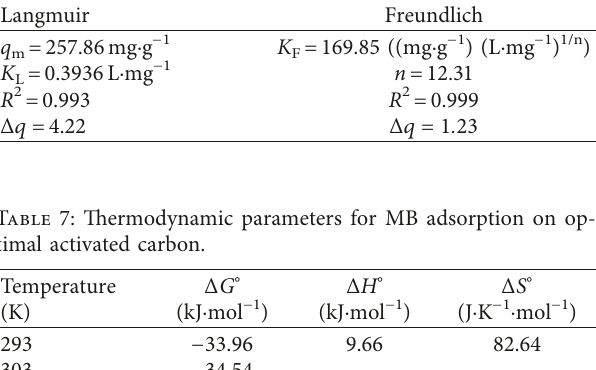
Figure 10: Plot of the intraparticle diffusion model for methylene blue adsorption onto activated carbon.